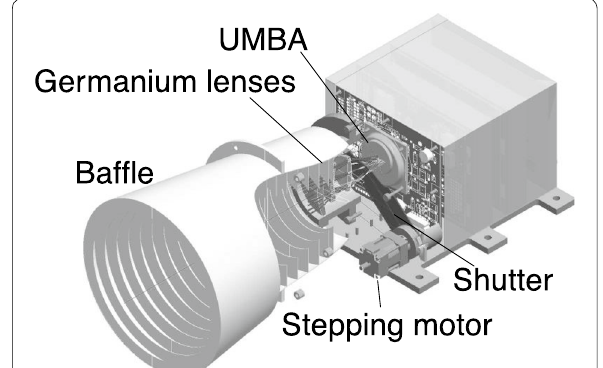
Fig. 1 Schematic of the internal layout of LIR referred from Fukuhara et al. (2011). The uncooled microbolometer camera works at room temperature. Hence, the baseplate on which the camera is mounted and the Ge lens on the camera are kept at room temperature by heaters. Temperature of the UMBA is controlled at 313 the Peltier device to keep high sensitivity. Temperature of the baffle residing outside of the spacecraft varies with the solar incident